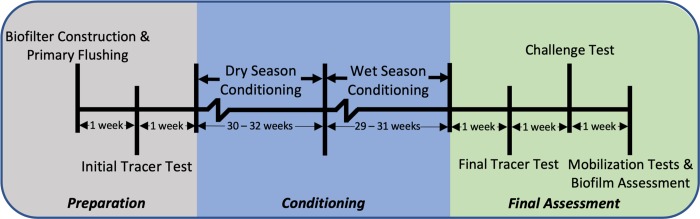
Timeline of the experiment.